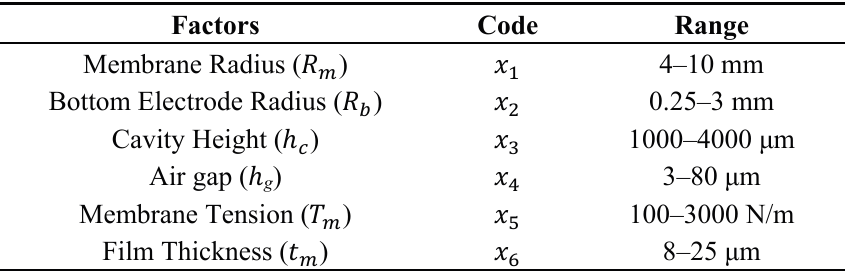
Table 3. List of experimental variables (factors) and their ranges.